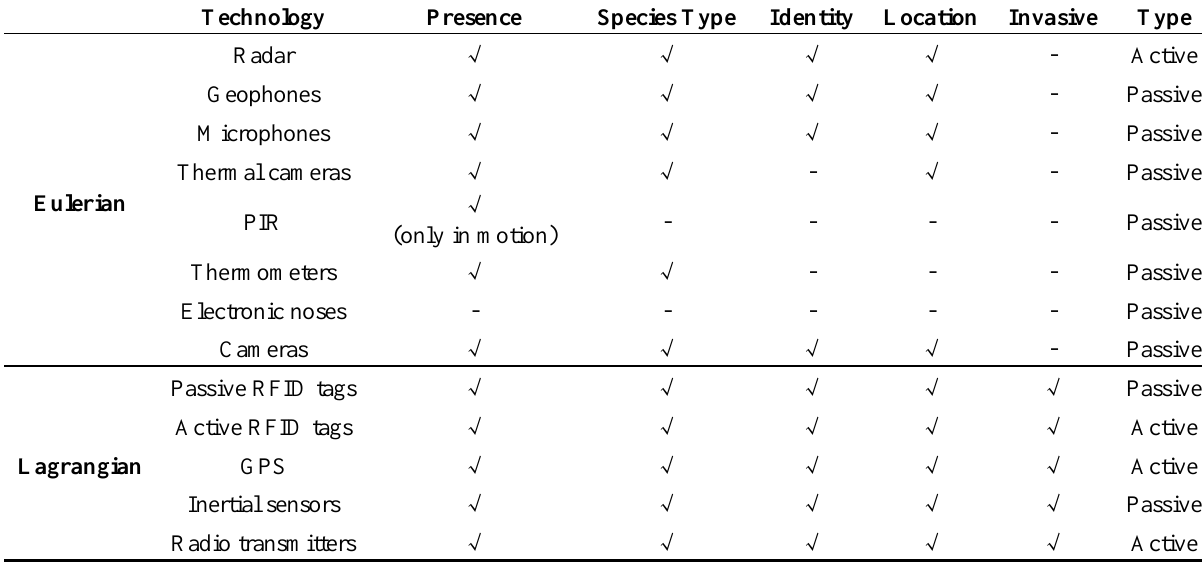
Table 1. Comparison of sensing technologies in terms of spatio-temporal features they provide.